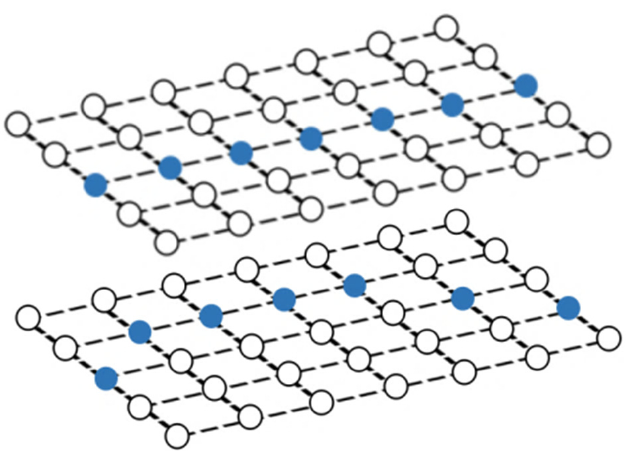
Figure 3. A schematic diagram of a standard pixel array structure.